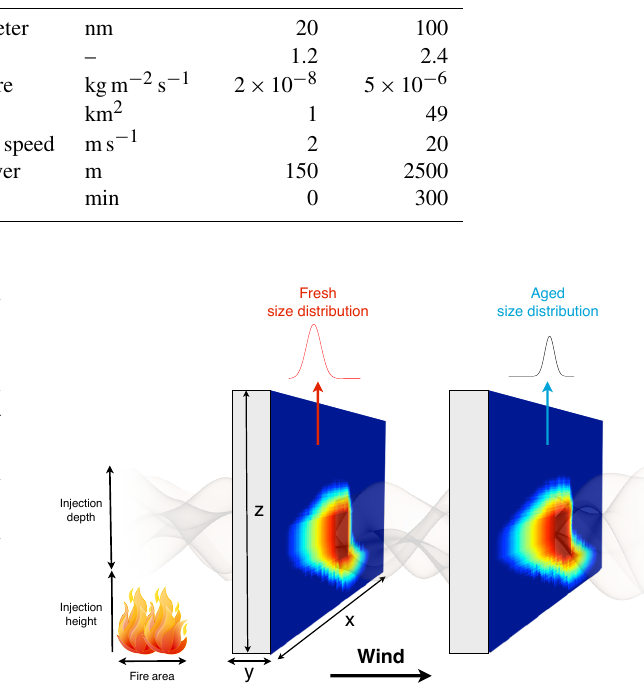
Table 1. Parameter ranges for each of the seven input parameters investigated in this study. Parameter Description